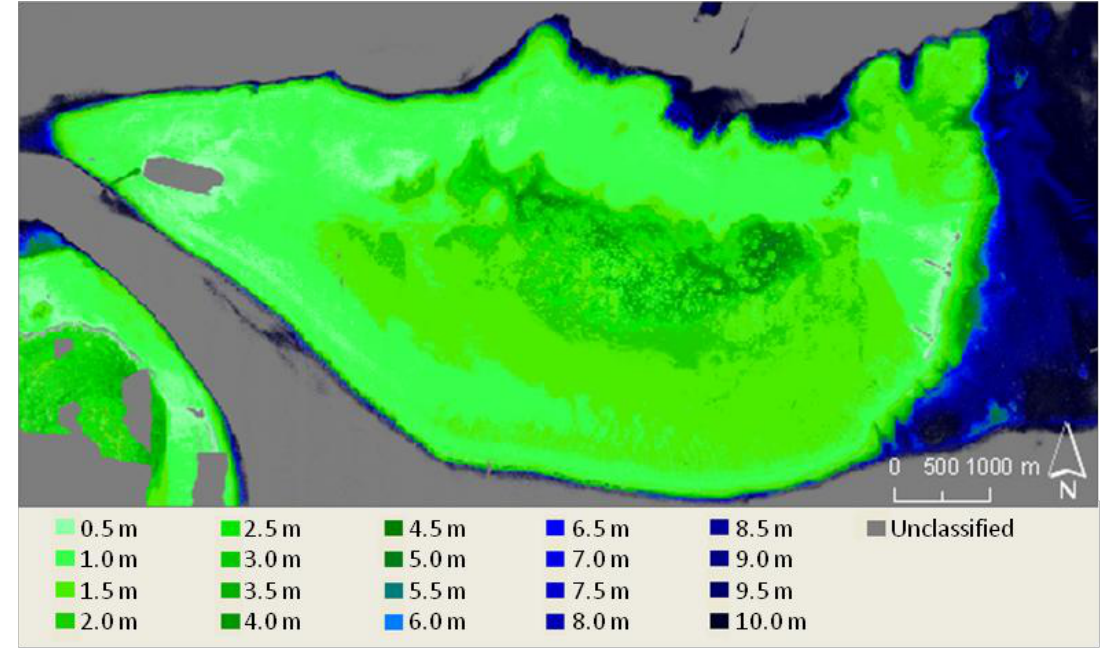
Figure 5. Heron Reef bathymetry classified image; showing the internal lagoon with a maximum depth of around 5.0 m, a shallower reef flat, and a harbour which is around 4.0 m on average. Waters beyond the reef slope, and known to be greater than 10 m deep, were